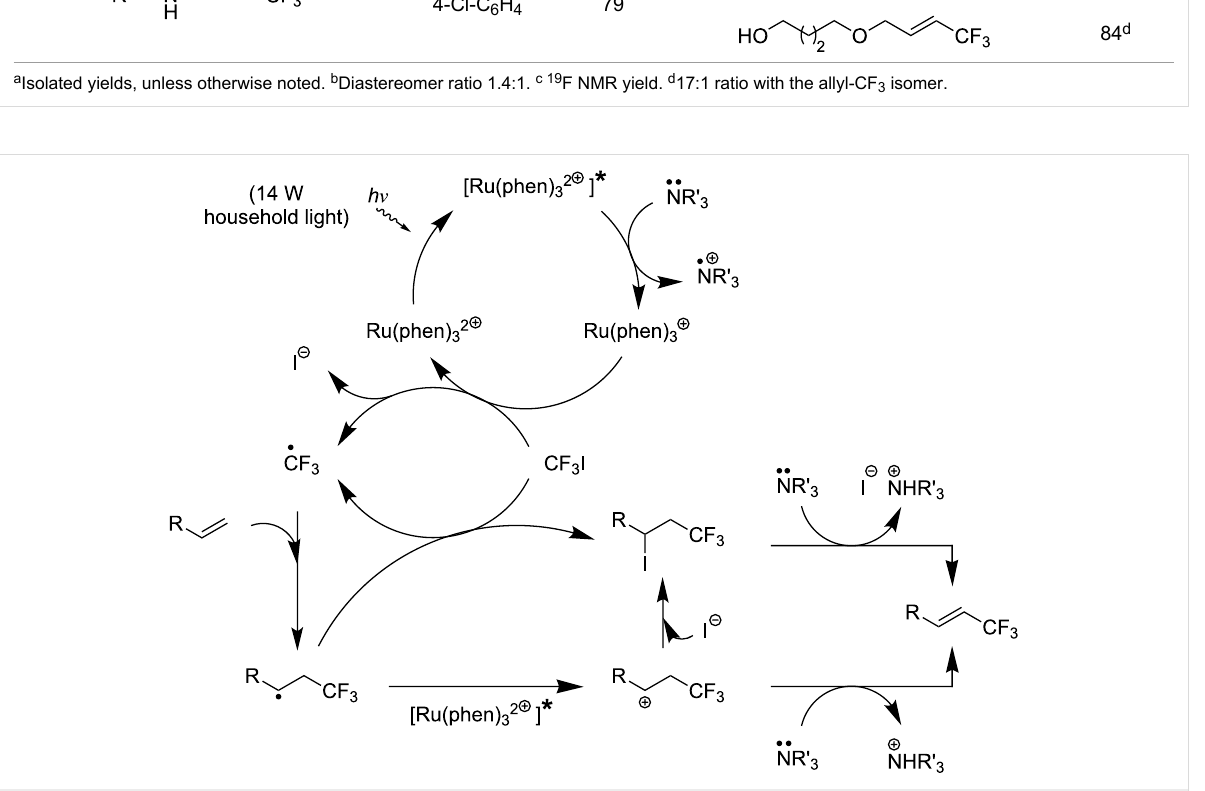
Figure 17: Proposed mechanism for the trifluoromethylation of alkenes with trifluoromethyl iodide under Ru-based photoredox catalysis (E. J. Cho et al.) [106].